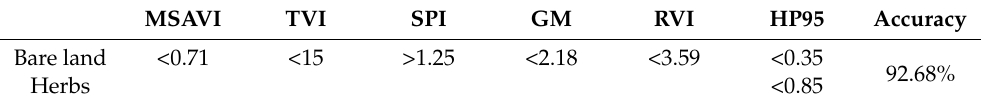
Table 4. Extraction of vegetation indices of grassland and bare land by a decision tree